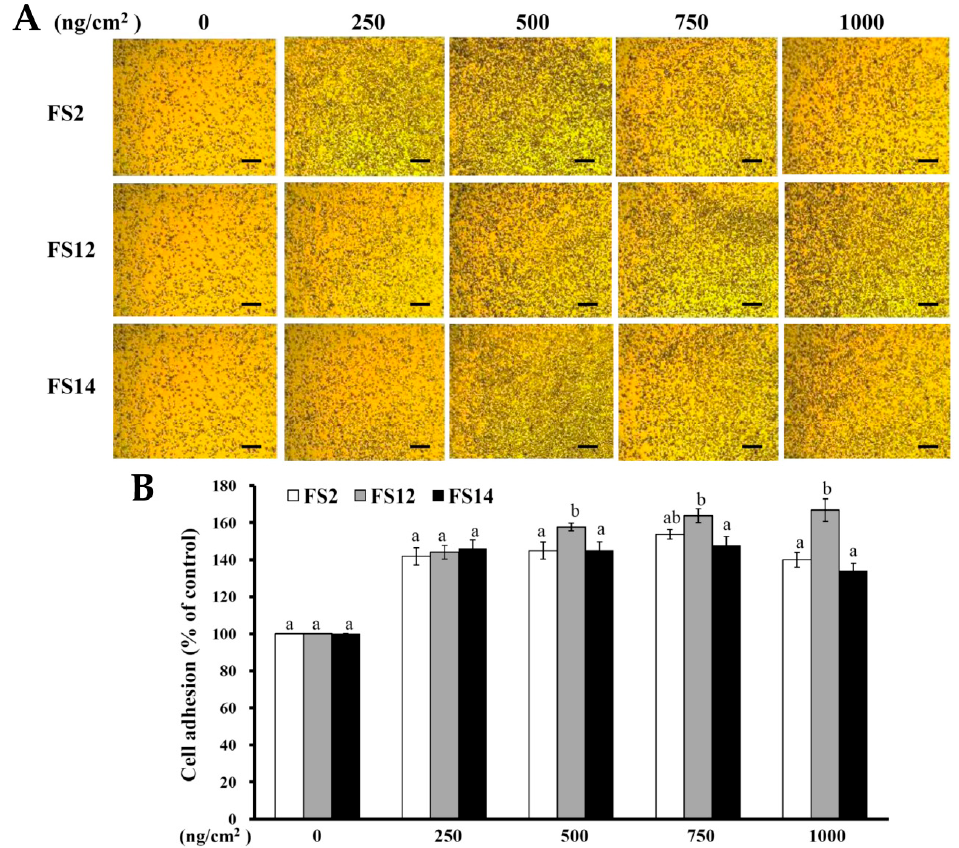
Figure 2. Effects of FS2, FS12, and FS14 on cell adhesion in HaCaT cells. ( A ) FS2, FS12, and FS14 were coated on the surface of plates at different concentrations, and then the HaCaT cells were seeded onto these plates; after 45 min, the cell adhesion activity was assessed, bar = 250 μ m. ( B ) The bar graph summarizes the three cell adhesive experiments and shows the percentage of cell adhesion for FS2, FS12, and FS14 at different concentrations. The data are represented as means ± SD ( n = 3). In each treatment concentration, different letters (in a and b) upon bars indicate significantly different ( p < 0.05).